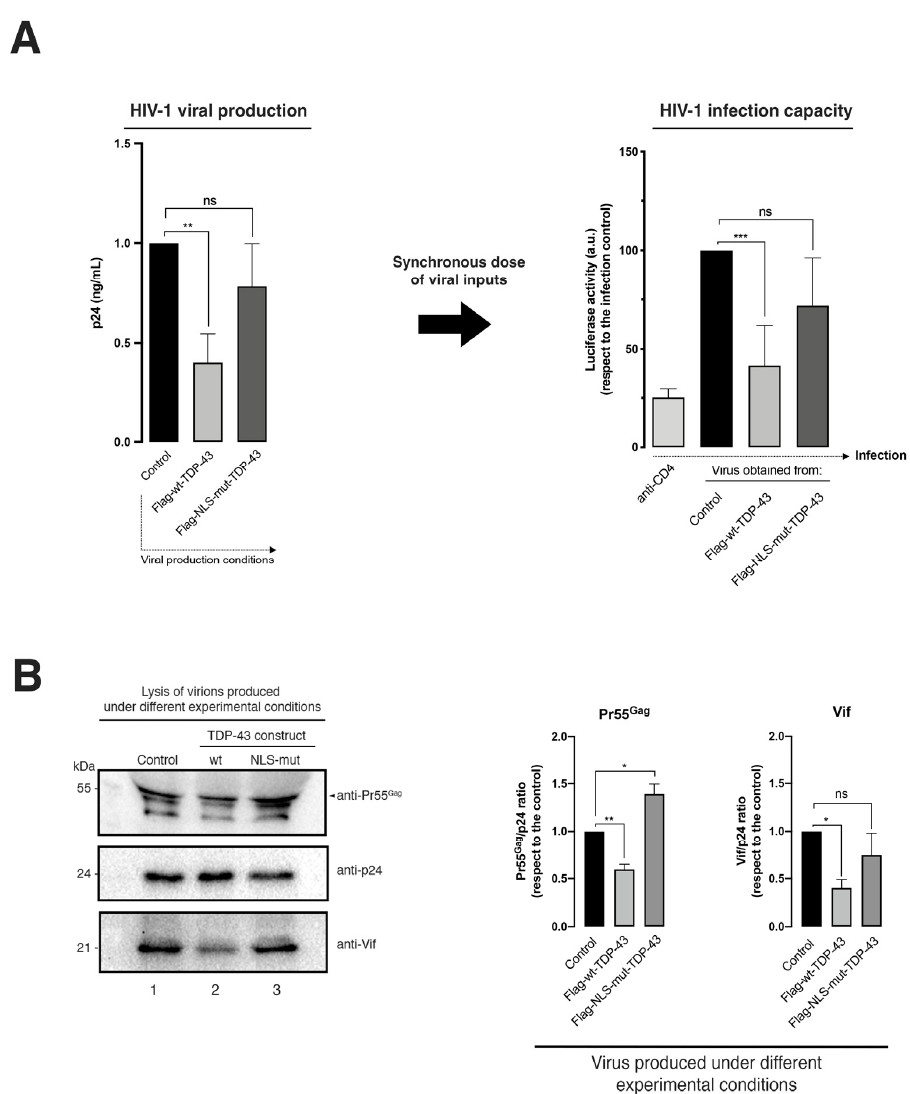
western blot analysis and quantification (right histograms, with respect to the load control protein total α -tubulin) of the wt-TDP-43- and NLS-TDP-43 mutant-mediated effect on HIV-1 Pr55 Gag and Vif protein clearance. Total α -tubulin for protein load control is shown under each experimental condition. Histogram-associated data for HIV-1 Pr55 Gag and Vif degradation are the mean ± S.E.M. of three independent experiments (data associated with the quantification of replicates in Figure S2B, Supplementary Materials section). The quantification of the Pr55 Gag and Vif clearance, with respect to the load control protein total α -tubulin, was analyzed in histograms on the right. Data are mean ± S.E.M. of three independent experiments (data associated with the quantification of replicates in Figure S2B, Supplementary Materials section). When indicated, ** p < 0.01 is the p value for Student’s t test; ns, not significant.